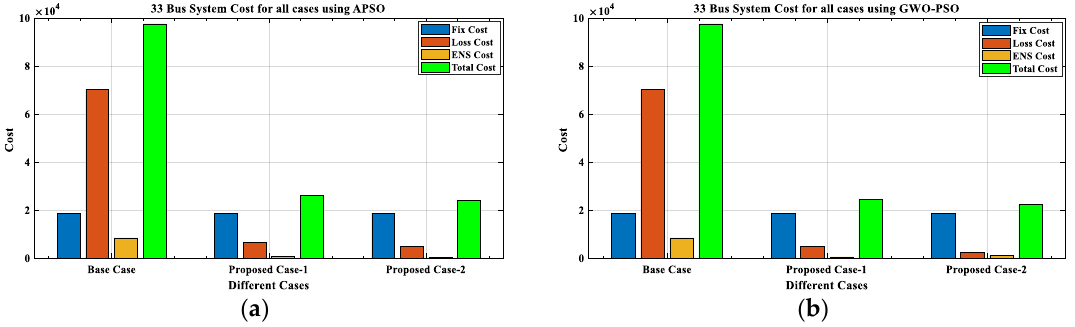
Figure 15. The fix, loss, and ENS cost for all the cases of 33-bus RDN; ( a ) APSO, ( b ) GWO-PSO.